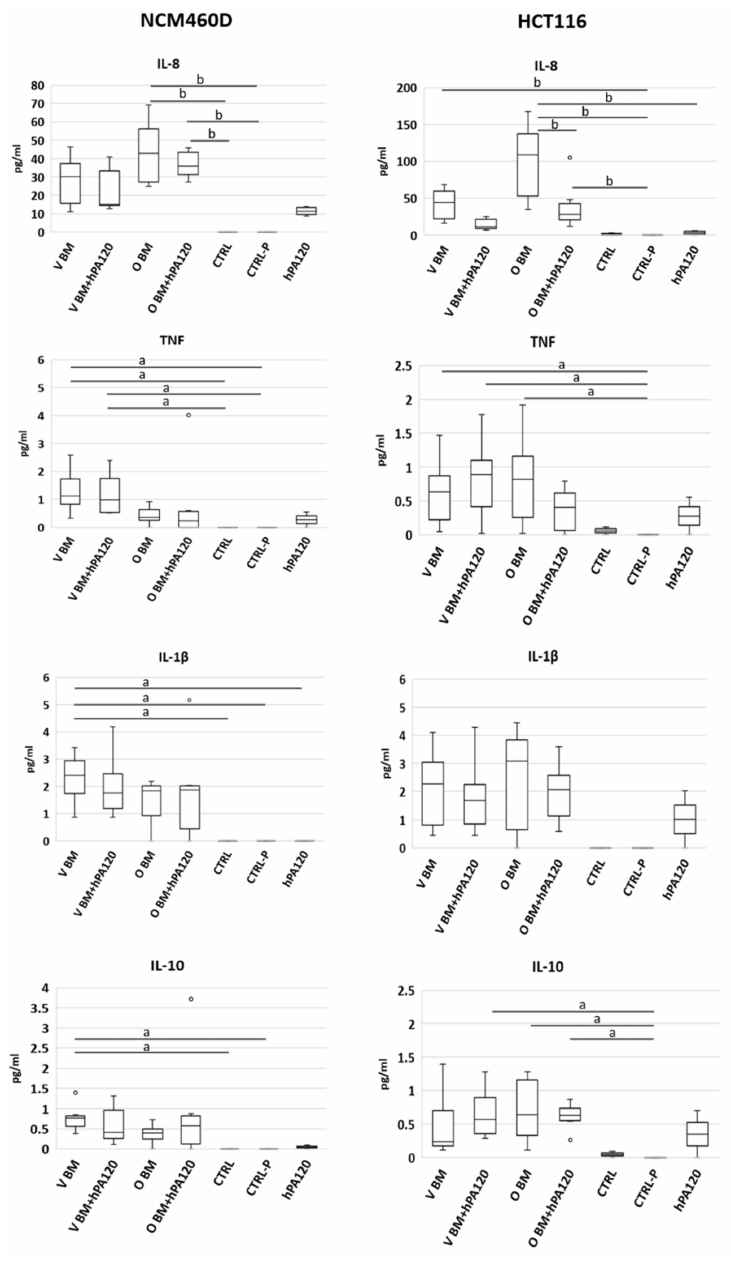
Figure 5. Secretion of interleukin 8 (IL-8), tumor necrosis factor (TNF), interleukin 1 β (IL-1 β ) and interleukin 10 (IL-10) by healthy (NCM460D) and cancer (HCT116) colonocytes. CTRL—non-treated (control) colonocytes; hPA120—colonocytes treated with phytate hydrolysate;